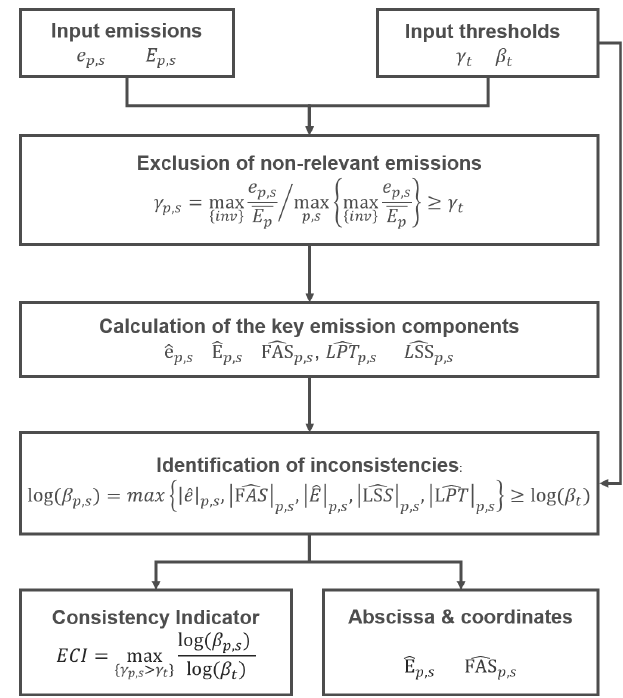
Figure 1. Flowchart of the steps to screen emission inventories. See details in the